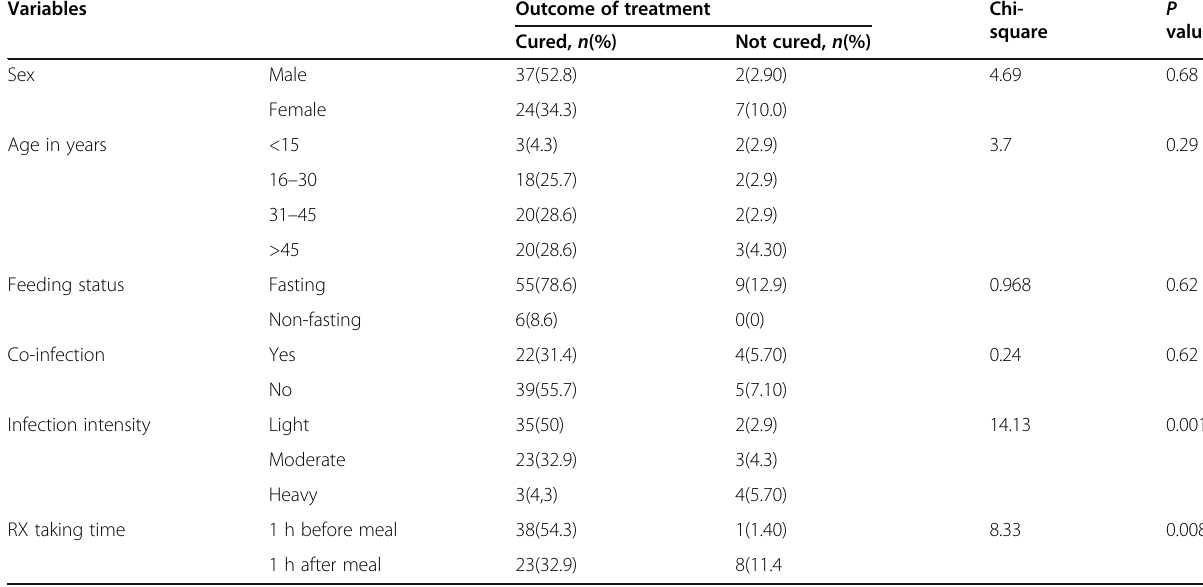
Table 4 Associated factors with cure rate of hookworm among patients ( n =70) Variables